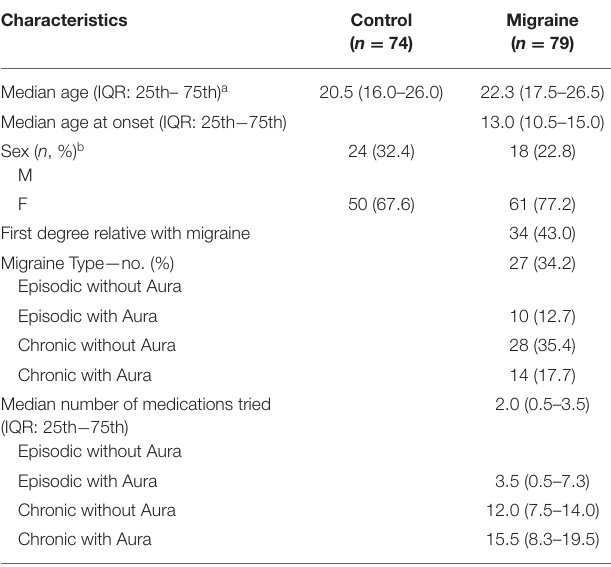
TABLE 1 | Clinical and Demographic